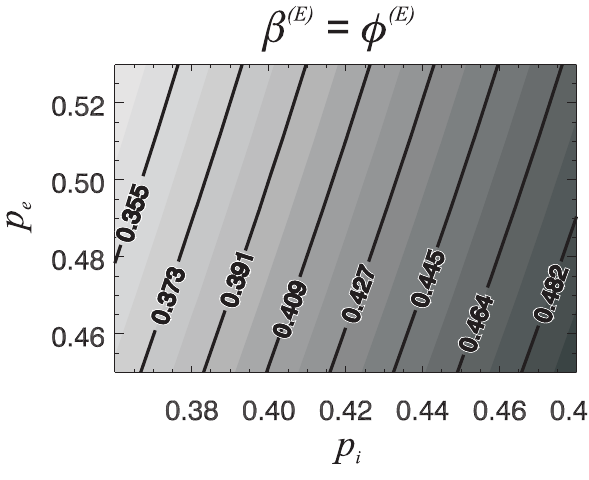
Fig. 14. Theoretical values for β (E) = φ (E) as functions of RSN